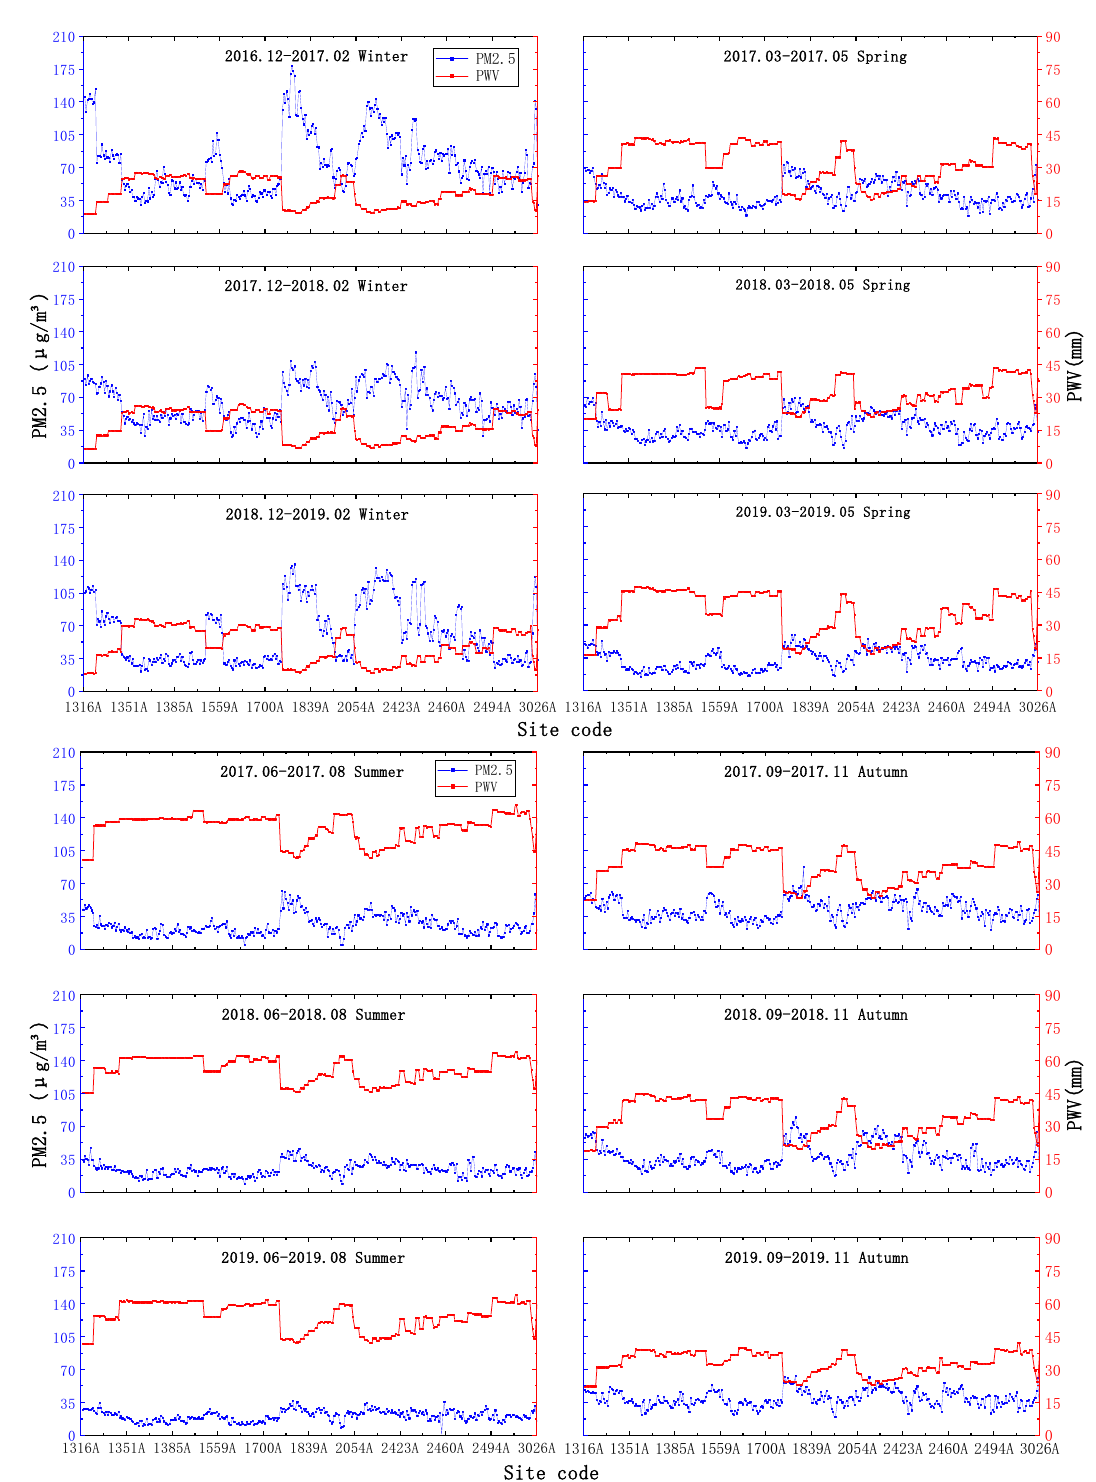
Figure 7. Seasonal average-scale PWV and PM 2.5 changes.